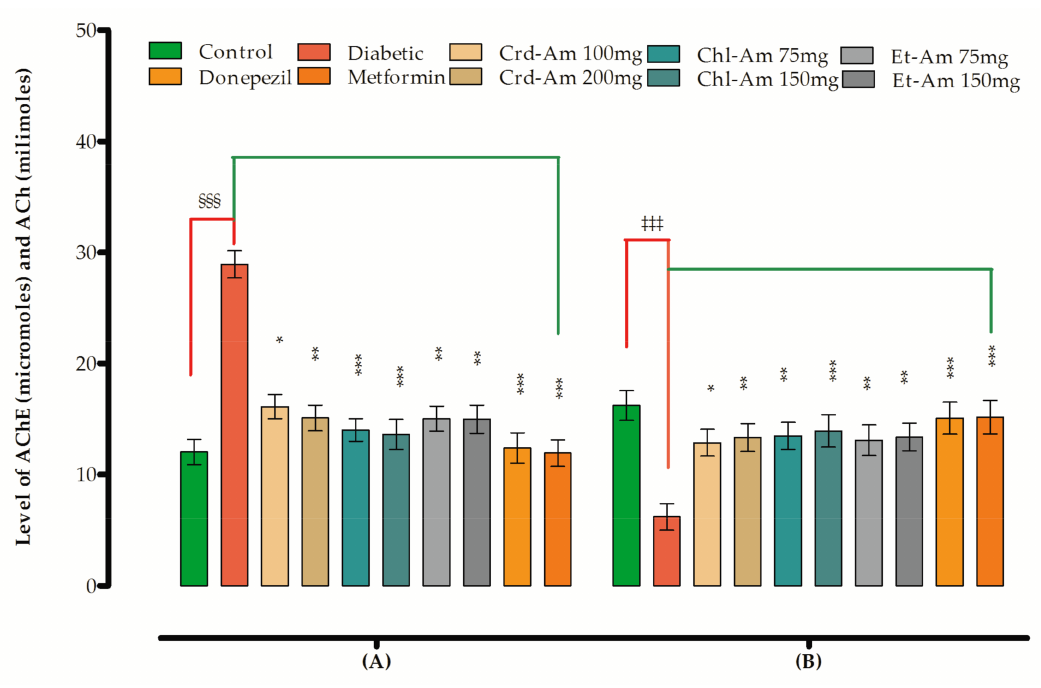
Figure 3. Effects of Crd-Am and fractions on ( A ) AChE and ( B ) ACh levels in brain. Mean ± SEM ( n = 6). One-way ANOVA is followed by Dunnett’s post hoc multiple comparison test. §§§ p < 0.001, ‡‡‡ p < 0.001 comparison of STZ-treated diabetic (amnesic) group vs. normal control, * p < 0.05, ** p < 0.01 and *** p < 0.001 in comparison with STZ-treated diabetic (amnesic) group vs. Donepezil-, Metformin-, crude extract- and fraction-treated groups using one-way ANOVA followed by Dunnett’s comparison. Crude extract (Crd-Am), chloroform (Chl-Am) and ethyl acetate (Et-Am)